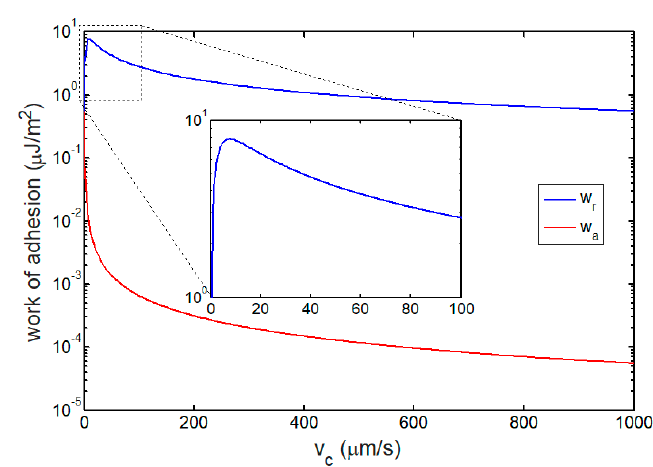
Figure 8. Work of adhesion as a function of cell speed. The inset is a partial enlarged drawing for the cell speed ranging from 0 µ m / s to 100 µ m / s. When v c → 0, the work of adhesion in quasi-static condition can be calculated as w QS = 0.54 µ J/m 2 .